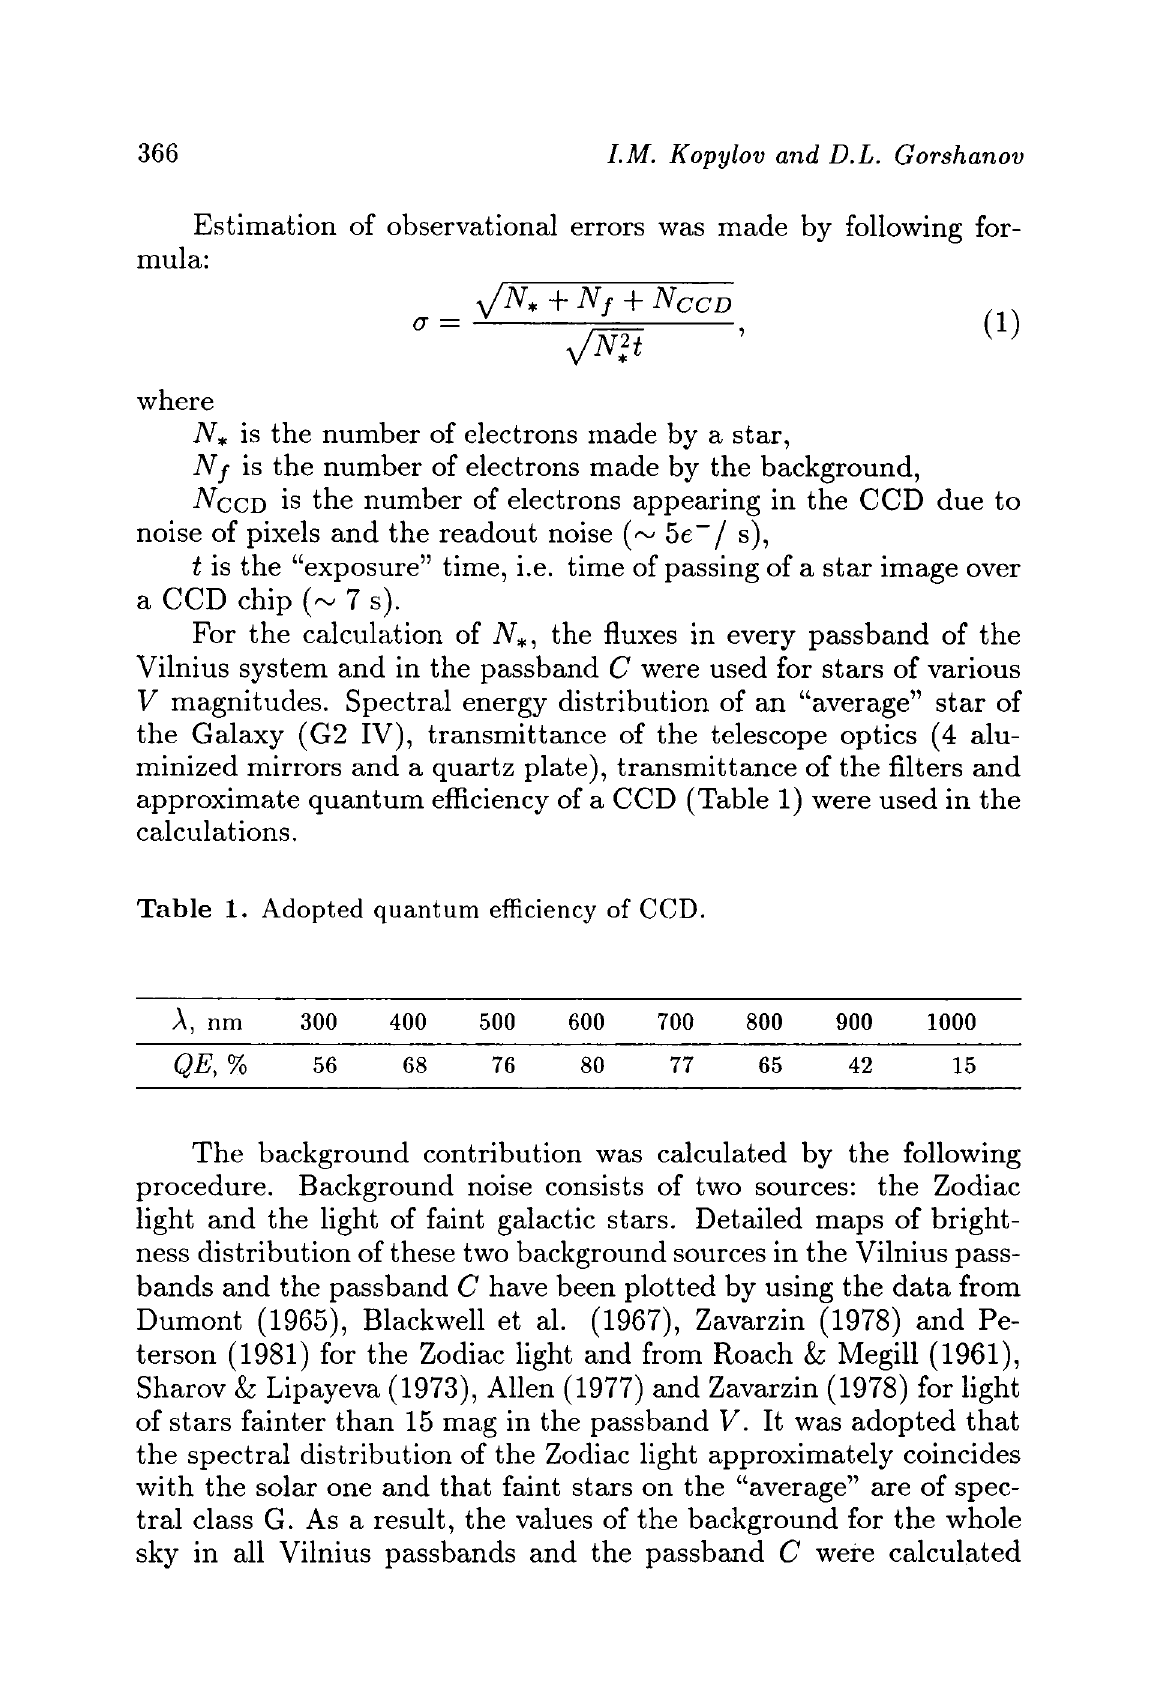
Table 1. Adopted quantum efficiency of CCD.